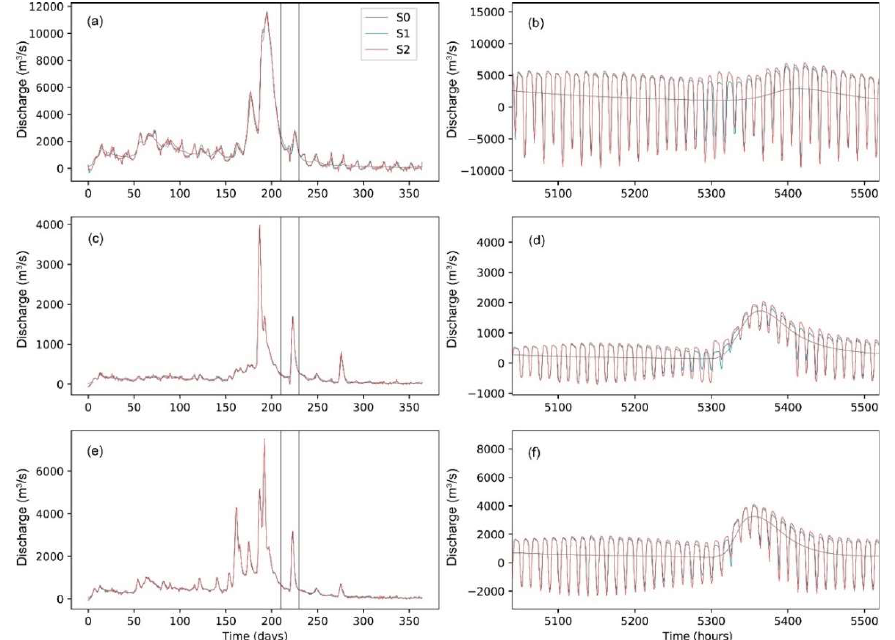
Figure 8. Variability in the river discharge at the three coastal unit catchments. ( a , b ), ( c , d ), and ( e , f ) represent the series in p0, p1, and p2, respectively. ( a , c , e ) show the different scenarios on a daily scale, and ( b , d , f ) show the variations on an hourly scale.